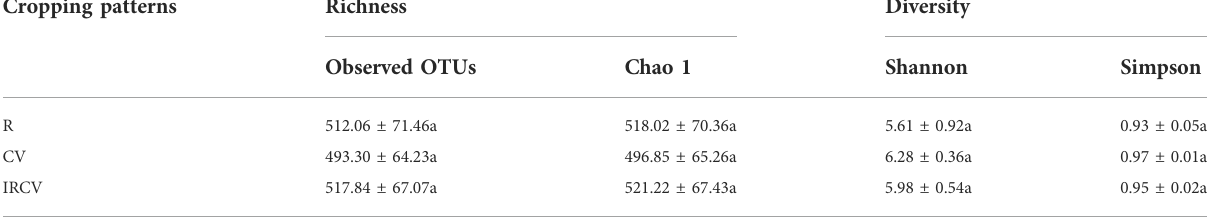
TABLE 4 Richness, diversity of the fungal communities of the rhizosphere soil under different treatments. Cropping patterns